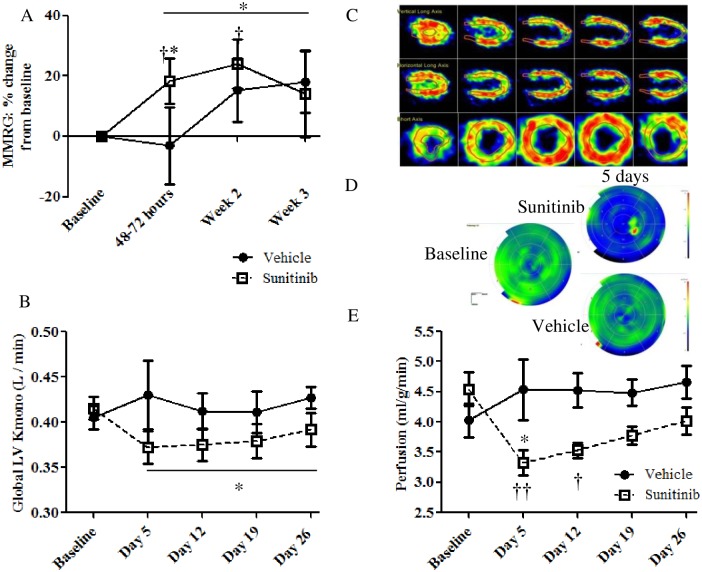
Effect of sunitinib treatment on myocardial metabolism and perfusion measured by PET.A) Myocardial metabolic rate of glucose (MMRG) (mice, n = 10/group), B) Kmono (rats, n = 6/group). C-E) The effects of sunitinib treatment on overall perfusion of the myocardium in the rat model: (C) Representative images of the myocardium as seen in Carimas software (version 2.7) which is used to select region of interest (ROI), subsequently used to construct 17 segment heat maps for the 11C-Acetate data (rats) (D) which are used to determine global perfusion values. D) Representative pre- and 5 days post-treatment in one treated and one vehicle rat E) The effects of sunitinib treatment on overall perfusion of the myocardium (rats, n = 6/group, * = significant difference between groups (unpaired t-test, p<0.05), Significant change from pre-treatment (paired t-test, †p<0.05 ††p<0.01), bar* indicates significantly different overall on-treatment values (two-way ANOVA p < 0.05) Error bars = SEM).